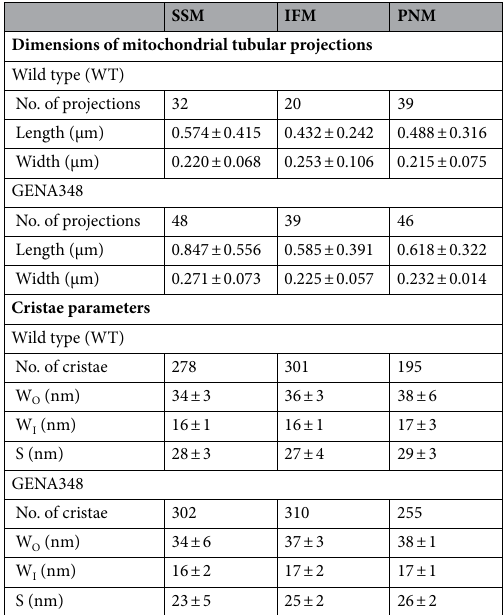
Table 2. Summary of mitochondrial morphological features. N = 3 per group. Data are presented as the mean ±